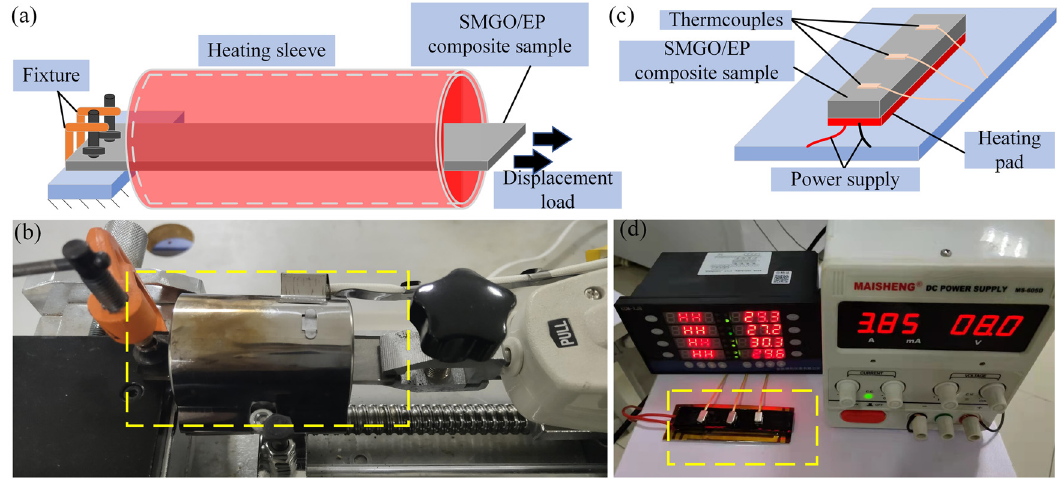
Figure 3: Schematics of ( a ) shape memory process, ( b ) heat transfer experimental devices of shape memory process, ( c ) and ( d ) heat sensor